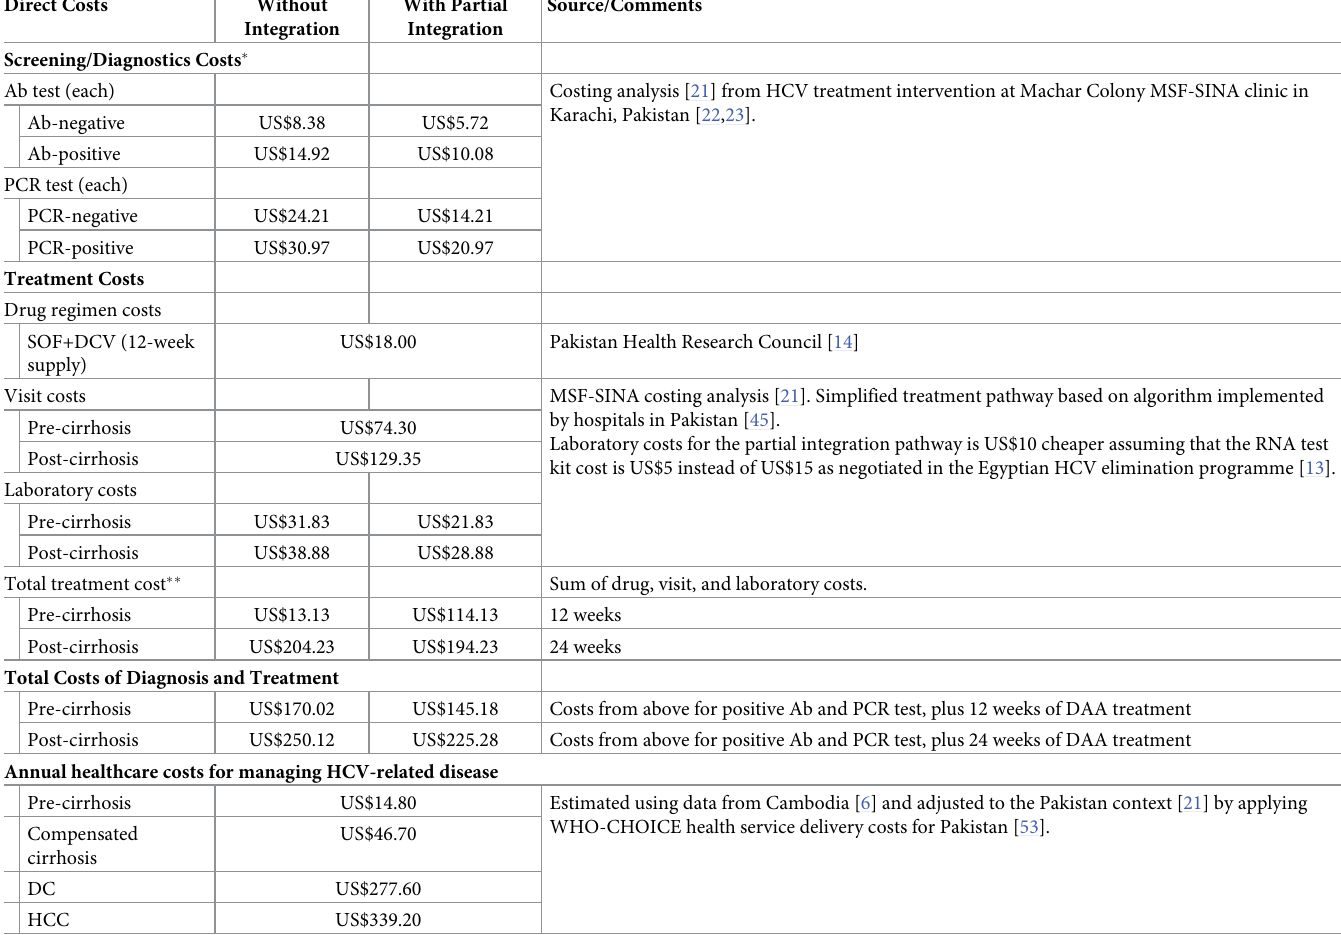
Table 1. Direct testing, treatment, and healthcare management costs used in the modelling analyses. This includes the unit costs of HCV screening and treatment and estimated annual costs of managing chronic HCV infection by disease progression stage. These cost estimates are used in both intervention scenarios (status quo and elimination) and for each of the economic perspectives (A, B, and C). All costs are in 2018 US dollars